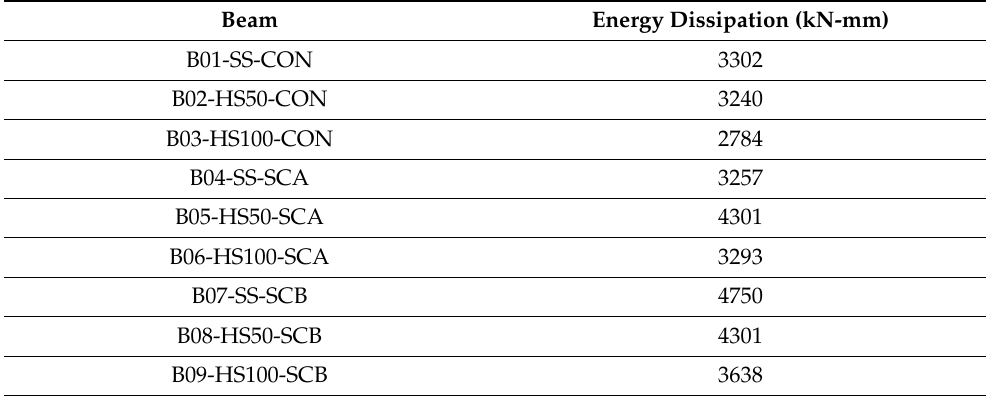
Table 5. Energy dissipated by